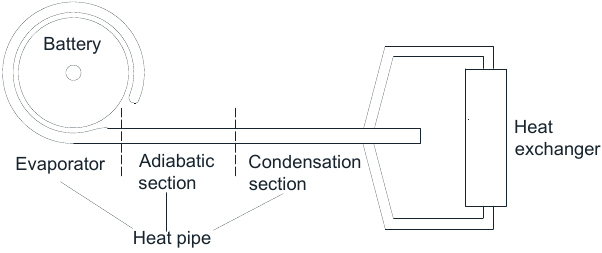
Figure 2. A thermal management model for a single battery utilizing heat pipe technology.